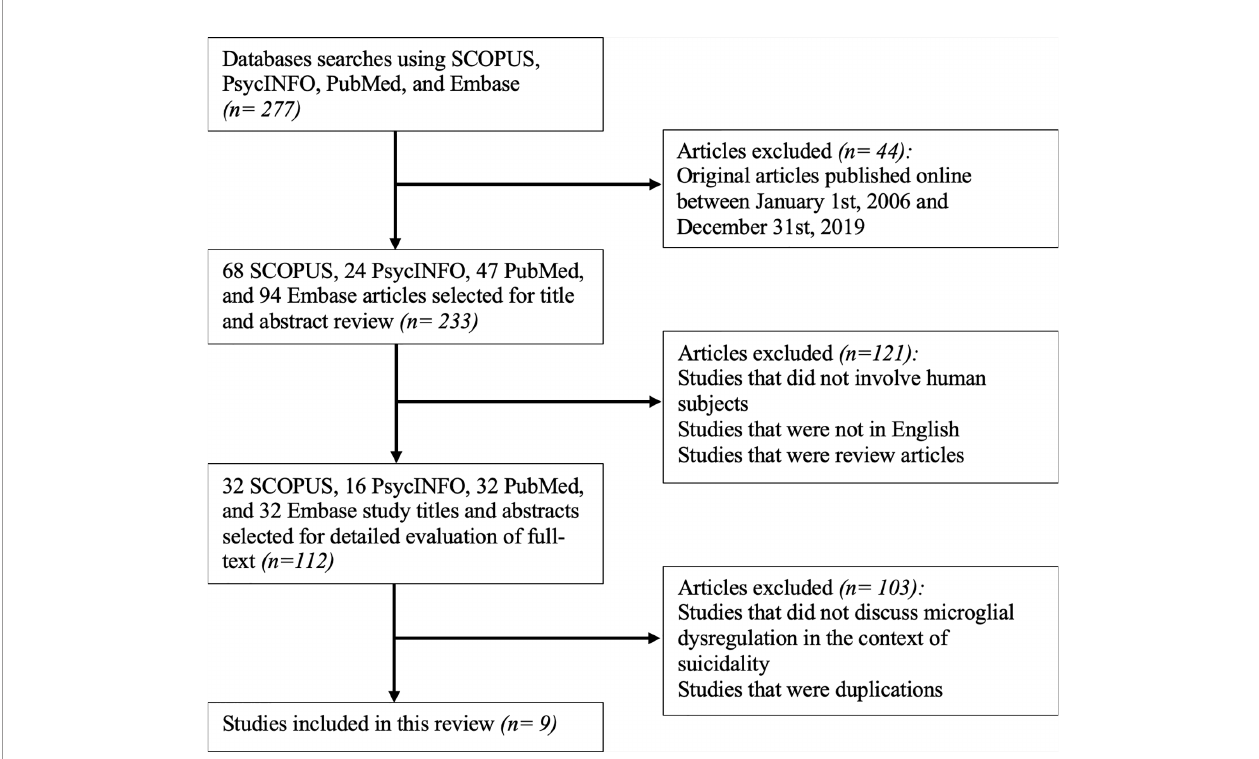
FIGURE 1 | Flowchart for the inclusion of appropriate original articles. This fl owchart showcases the selection process for the inclusion of articles for review according to the PRISMA statement